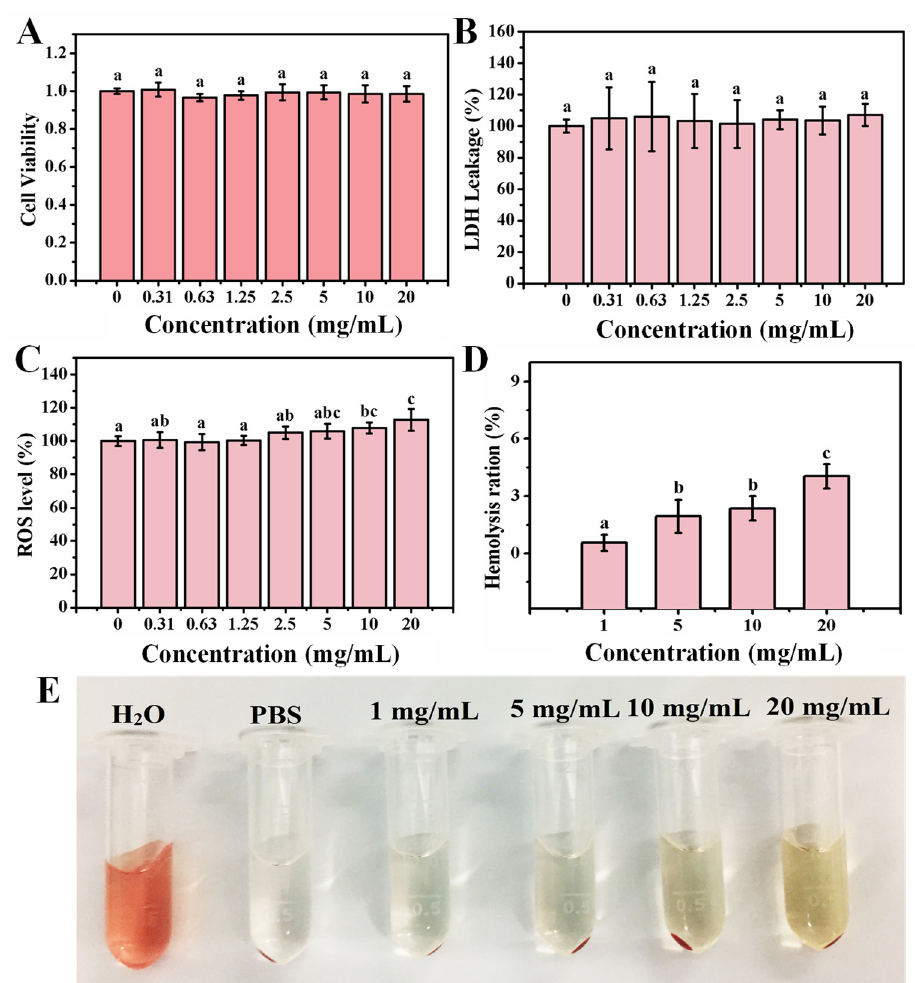
Figure 3. ( A ) Relative cell viability of MC3T3-E1 cell, ( B ) relative LDH release level of MC3T3-E1 cell, ( C ) relative ROS values of MC3T3-E1 cell after incubation with different concentrations OCNPs from the grilled turbot for 24 h. ( D ) Hemolysis ratio of red blood cells, ( E ) changes of red blood cells after incubation with different concentrations OCNPs for 1 h. Different letters above columns indicate significant differences ( p < 0.05) between